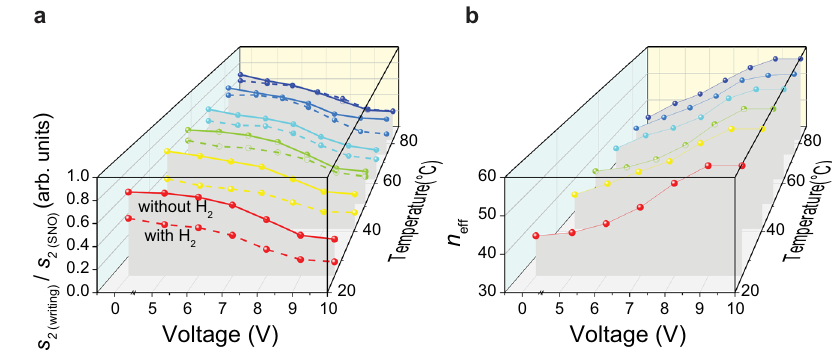
Fig. 3 | Nanoscale control of the local conductivity of SNO. a 3D plot showing changes in normalized amplitude s 2 (writing) / s 2 (SNO) ( z -axis) as a function voltage ( x -axis)andtemperature( y -axis)onthepristineandhydrogendopedSNOsamples.